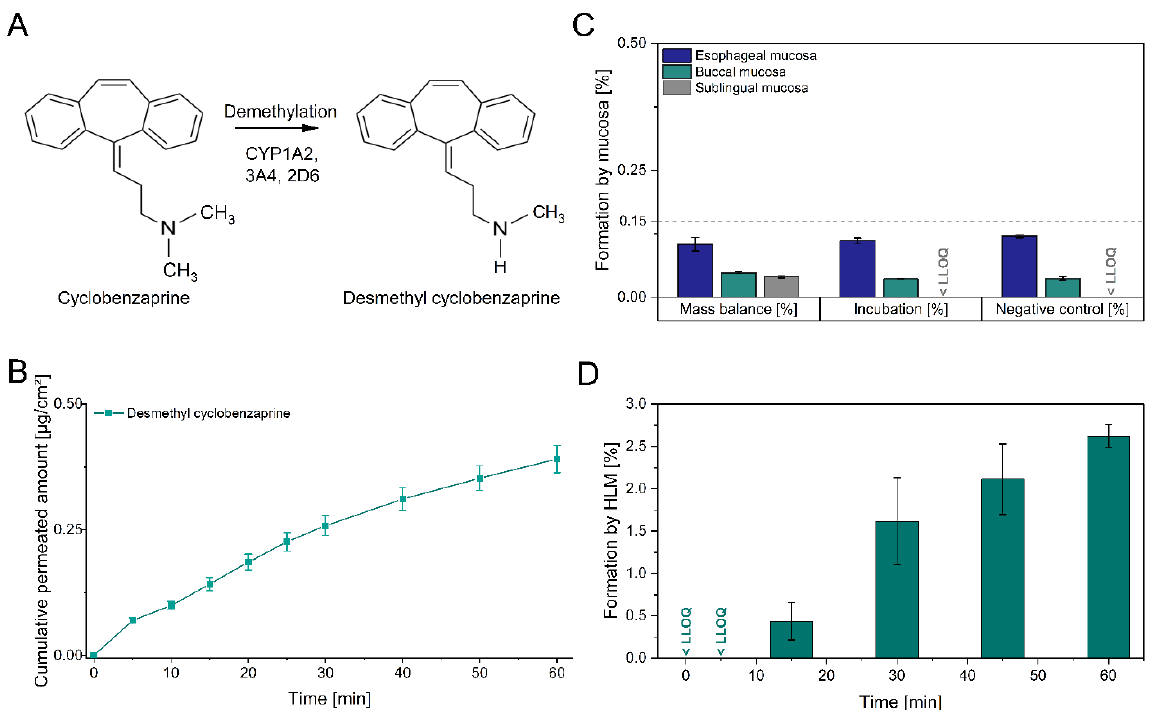
Figure 3. Cytochrome P450 metabolism of cyclobenzaprine. A : Scheme of cyclobenzaprine demethylation by CYP isoenzymes. B : Cumulative amount of permeated desmethyl cyclobenzaprine per cm 2 (mean ± SEM; n = 8). C : Formation of desmethyl cyclobenzaprine by different mucosae and approaches (mean ± SEM; n ≥ 2). D : Formation of desmethyl cyclobenzaprine by human liver microsomes per time (mean ± SEM; n = 3). HLM: human liver microsomes, LLOQ: lower limit of quantification.